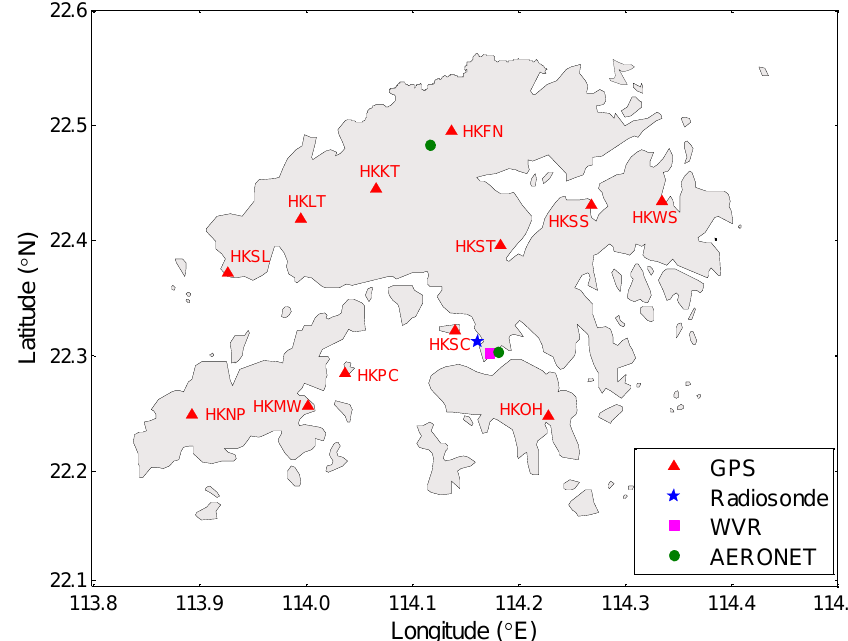
Figure 1. Geographical distribution of GPS, radiosonde, WVR and AERONET stations in Hong